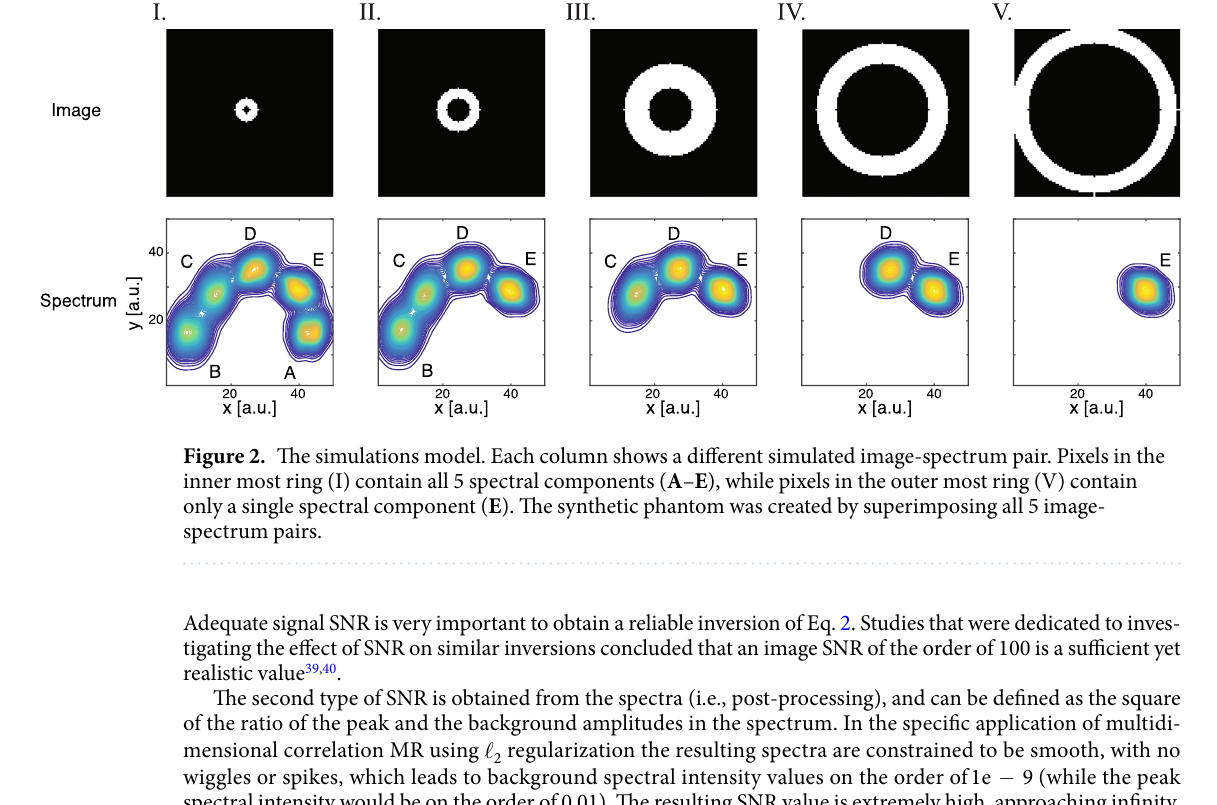
Adequate signal SNR is very important to obtain a reliable inversion of Eq. 2. Studies that were dedicated to inves- tigating the effect of SNR on similar inversions concluded that an image SNR of the order of 100 is a sufficient yet realistic value 39,40 .